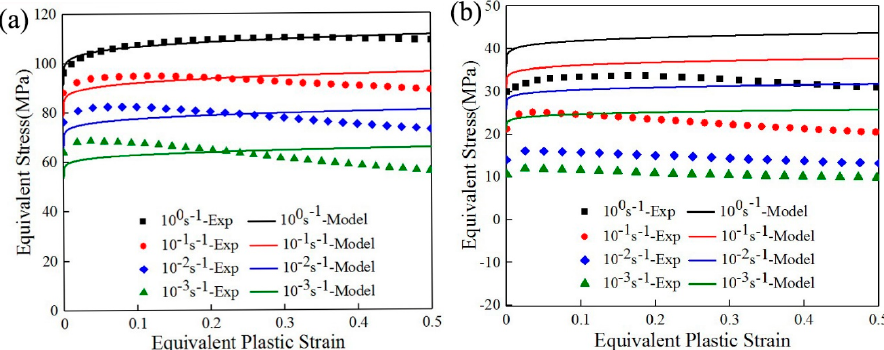
Figure 3. Comparison between the experimental data and the predictions ( a ) 573 K; ( b ) 773 K.